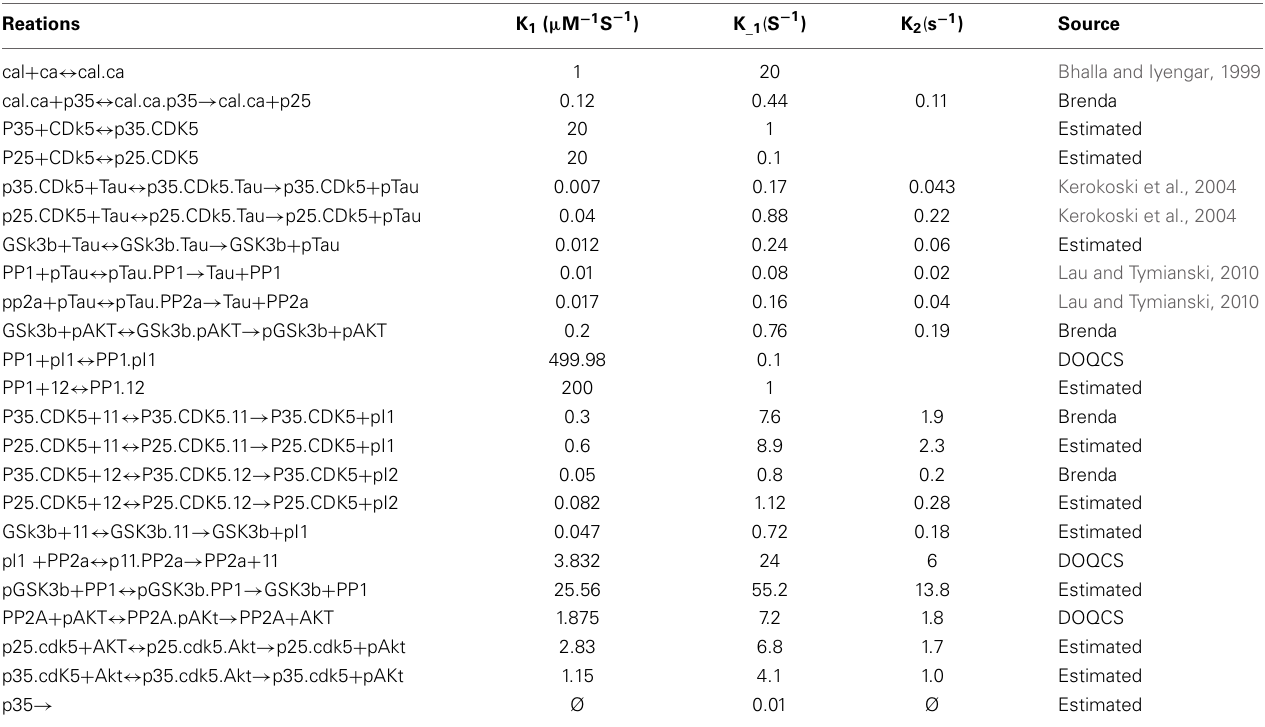
Table 1 | Reactions and velocity